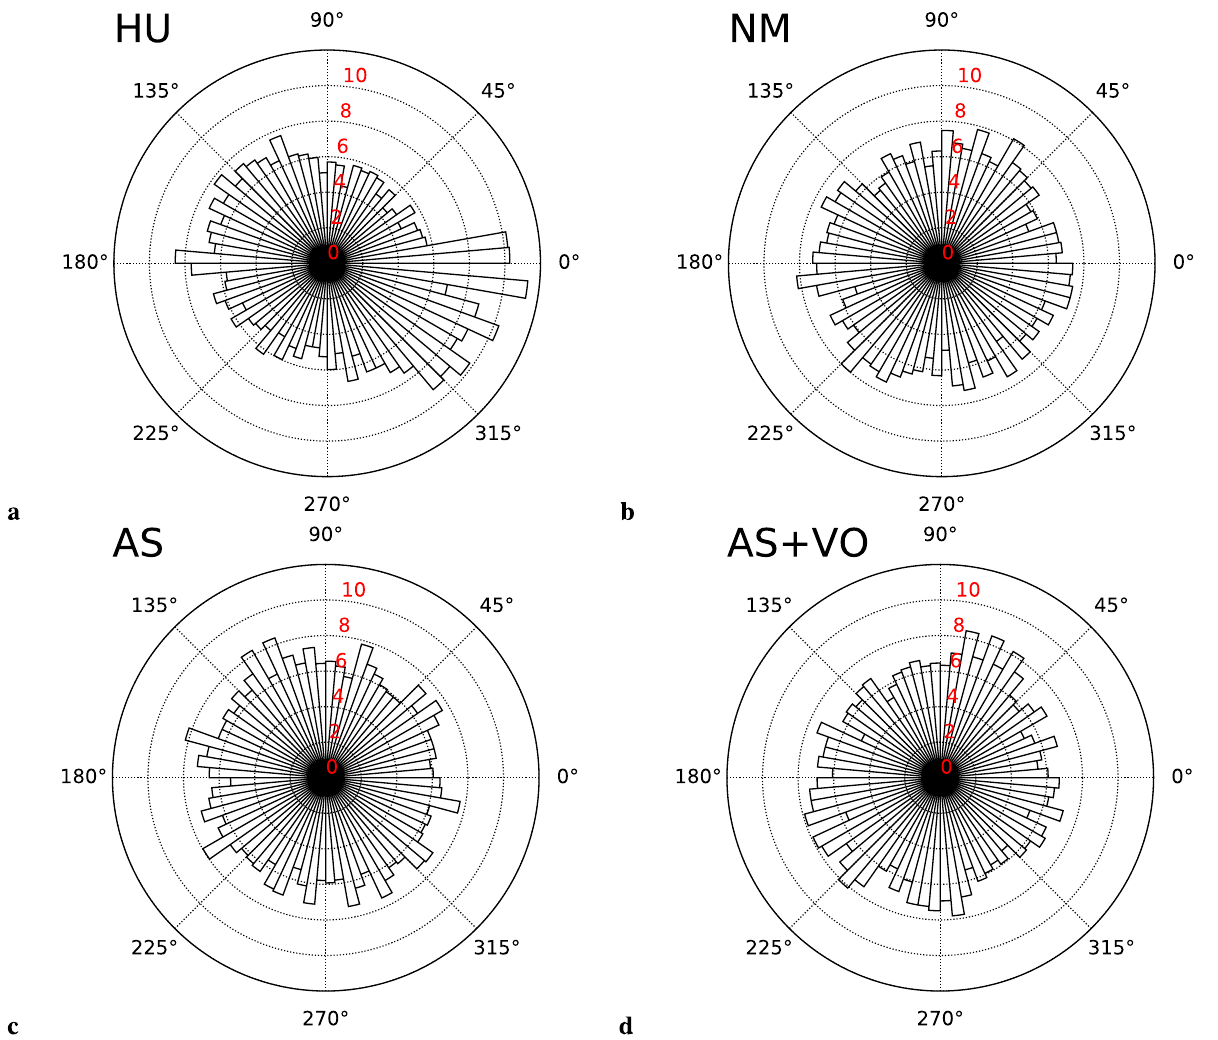
Figure 2. The circle histograms of four conditions which show the proportion of obtained gait phase differences at every five deg. The height in radius direction shows the normalized range of 0–12both HU (p < 0.0001) and AS + VO (p = 0.0485) conditions. At the same time, there was no significant distribution bias for NM (p = 0.9566) and AS (p = 0.0919)